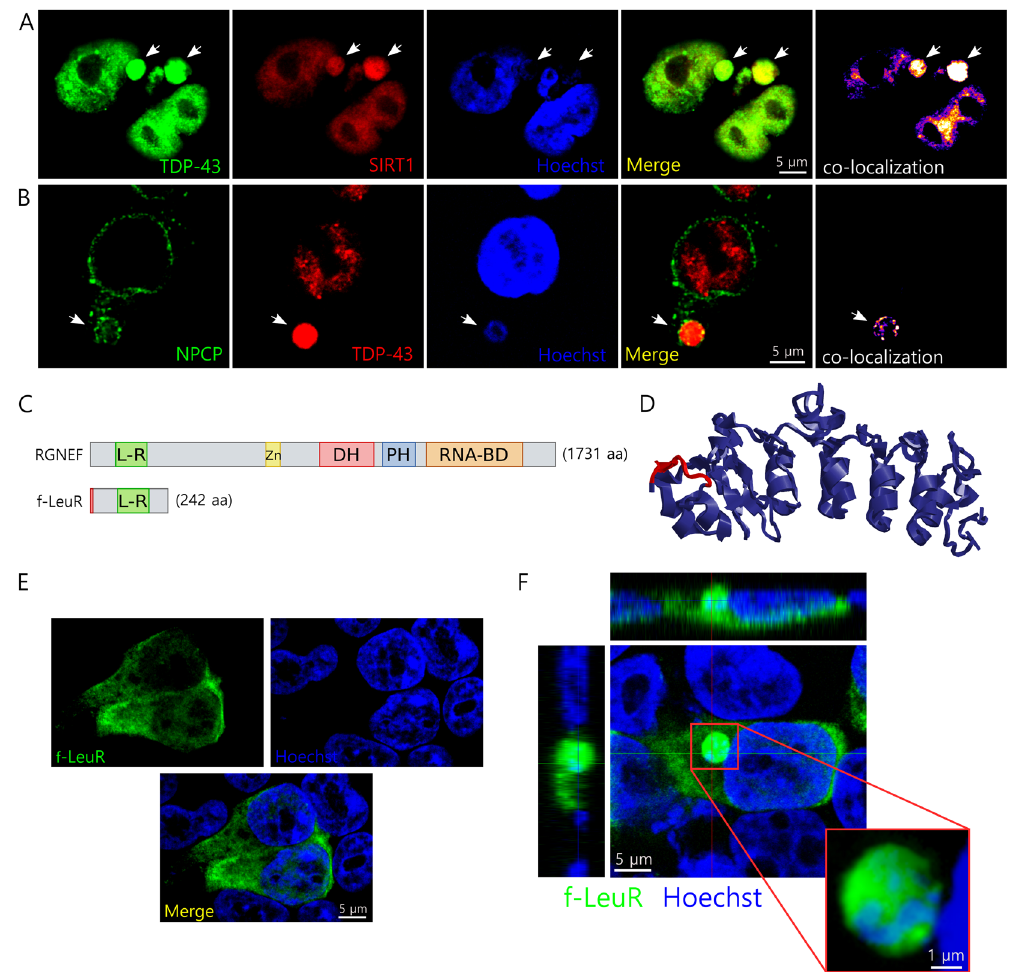
cells using different nuclear markers. Immunofluorescence primary antibodies used were: anti-flag ( A ), anti- TDP-43 ( A , B ), anti-sirtuin 1 (SIRT1) ( A ) and anti-NPCP ( B ). Hoechst was used as nucleic acid staining. Scales are indicated in the images. ( C ) Schematic of the flag-tagged RGNEF construct containing the LeuR domain (f-LeuR) used in the experiments compared with full length RGNEF. Abbreviations: L-R = LeuR domain; Zn = cysteine-rich Zinc binding domain; DH = Dbl homology domain; PH = Pleckstrin homology domain; RNA-BD = RNA-binding domain. ( D ) In silico prediction of f-LeuR structure using I-Tasser software (flag is highlighted in red). ( E ) Representative confocal showing the cellular localization of f-LeuR in basal conditions in HEK293T cells. ( F ) Representative confocal image of HEK293T cells showing a micronucleus (enlarge on inset) containing f-LeuR and nucleic acids after metabolic stress. Orthogonal sections are shown. f-LeuR was detected using mouse anti-flag antibody. Hoechst was used as nucleic acid staining. Scales are indicated in the